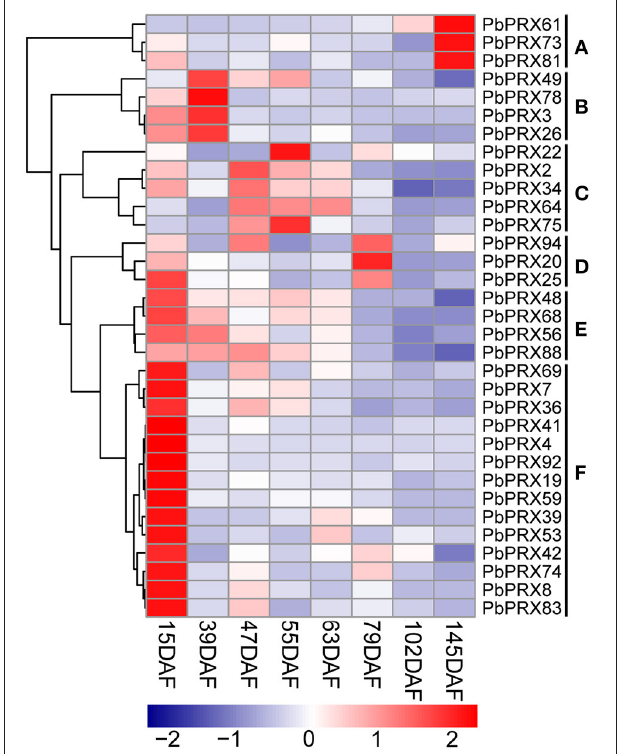
FIGURE 7 | Heat map representation of PbPRX genes the eight stages of pear fruit development, 15 days after flowering (DAF), 39 DAF, 47 DAF, 55 DAF, 63 DAF, 79 DAF, 102 DAF, and 145 DAF. These expression profile data were obtained using qRT-PCR, and relative expression was